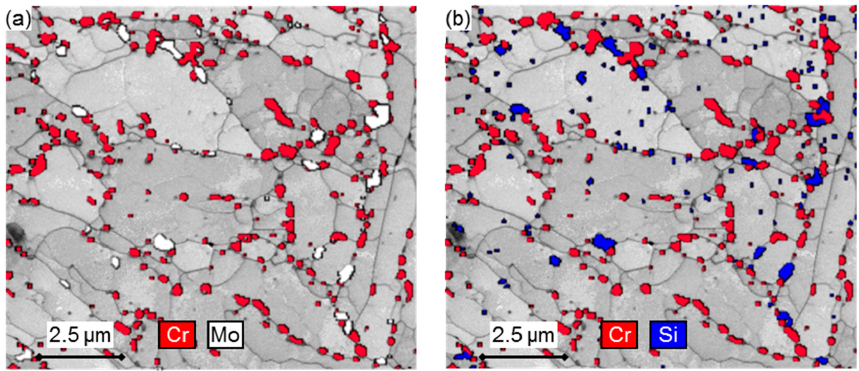
Figure 14. EDS maps of ( a ) Cr and Mo and ( b ) Cr and Si overlaid over Transmission Kikuchi Diffraction (TKD) band contrast maps in EXH material, indicating the location of carbides (Cr) and Laves phase particles (Mo and Si) along micro-grain boundaries. Materials 2019 , 12 , x FOR PEER REVIEW